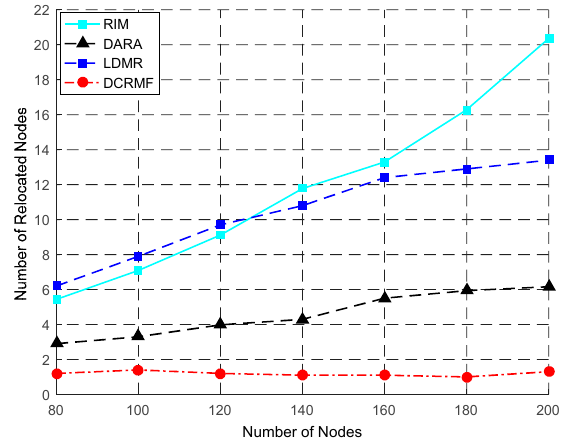
Figure 9. The relationship between the number of relocated nodes and the number of nodes by using these four algorithms. Table 4. Comparison of different methods on the change of average number of relocated nodes with the numbers of nodes varying.